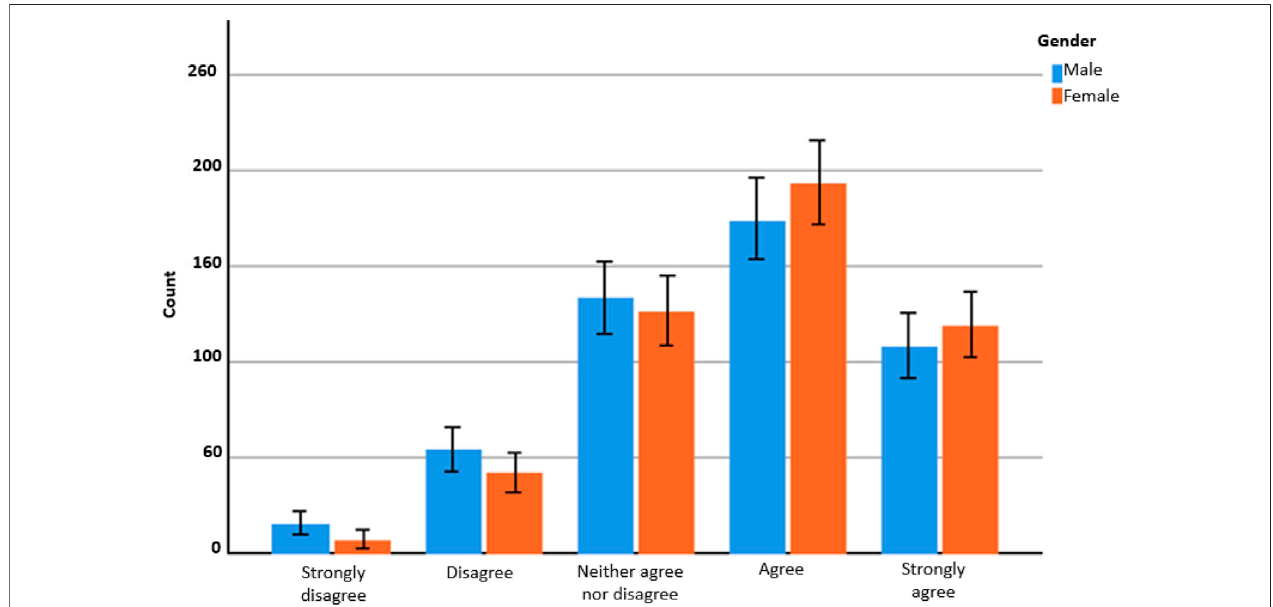
FIGURE 5 | Different in mean scores from the focus group of smart syetms attributes by gender ( n (cid:1) 18). Source, authors.